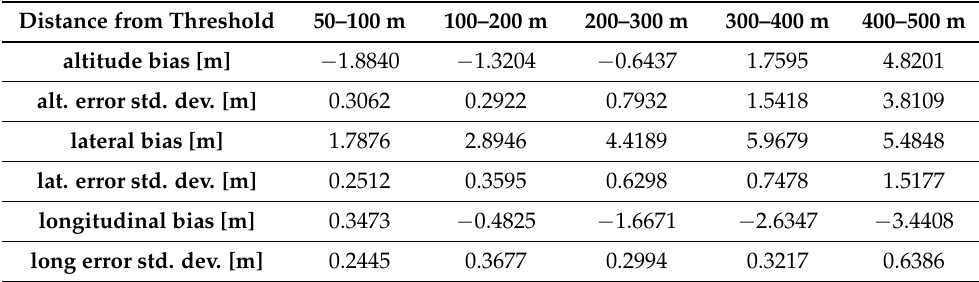
Figure 13. Longitudinal ( Z R [ m ]) error of four consecutive runway approaches at Septfonds. Table 1. Bias and standard deviation of navigation data in different distance intervals at Septfonds (average of 4